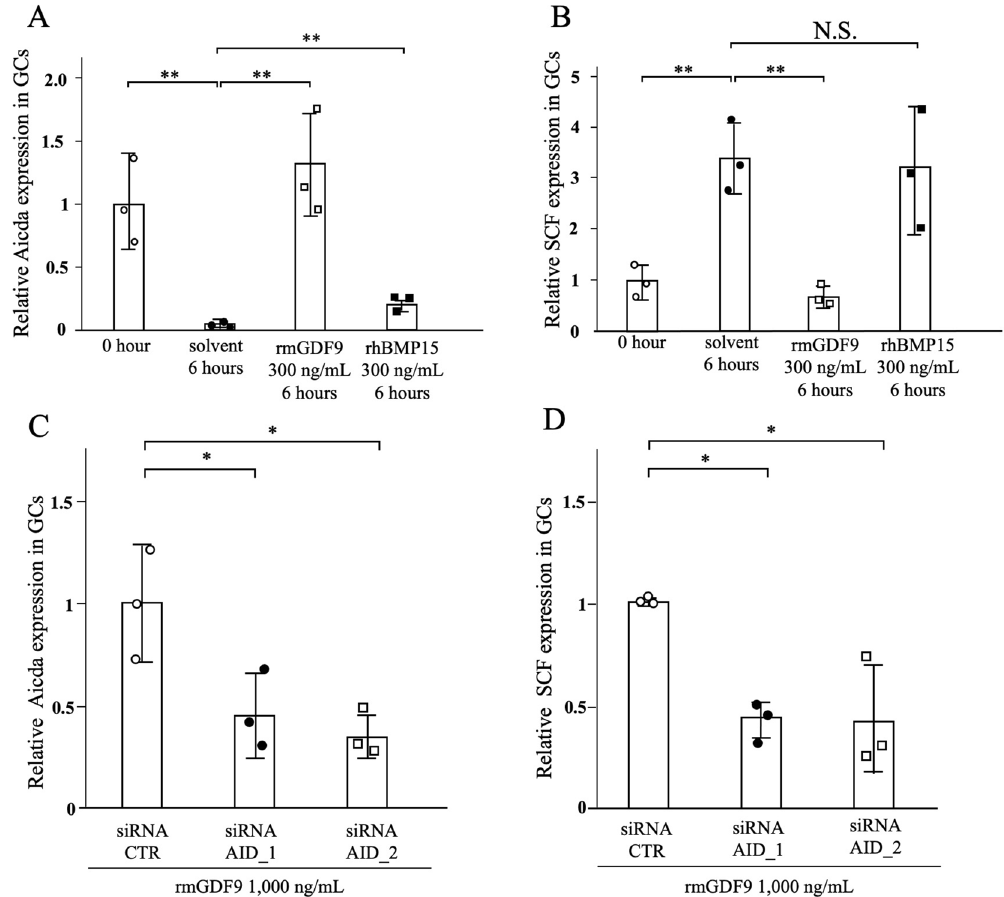
Figure 5. Regulation of SCF expression in cultured granulosa cells by GDF-9 and AID. ( A – D ) Granulosa cells isolated from the 3-week ovary of wild-type mice were subjected to the following culture experiments. AID and SCF expression relative to Gapdh in murine granulosa cells assessed by qPCR. ( A ) AID expression was markedly decreased during a 6-h culture. In contrast, AID expression was completely maintained in the presence of GDF-9. BMP-15 also showed enhancing effects on AID expression, but it recovered only a small part of the lost AID expression. ( B ) The mRNA expression of SCF was more than 3-times increased during a 6-h culture. This increase was completely suppressed by GDF-9. BMP-15 showed no effects on SCF expression in cultured granulosa cells. ( C ) In the presence of GDF-9, both siRNA-AID_1 and siRNA-AID_2 significantly suppressed the mRNA expression of AID during a 48-h culture. Under this condition, SCF expression was significantly reduced. *P < 0.05; **P <